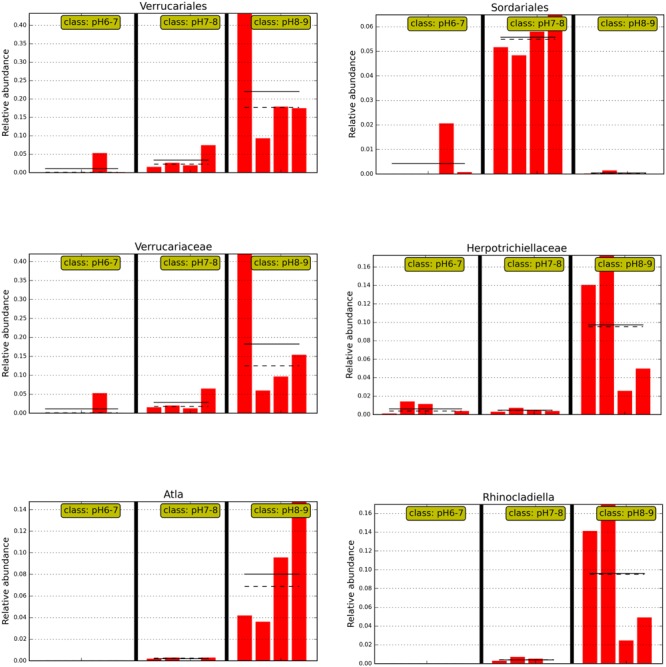
The abundance histogram of major taxonomic units (relative abundance >2%) which are significantly different among three soil pH levels using Lefse analysis.